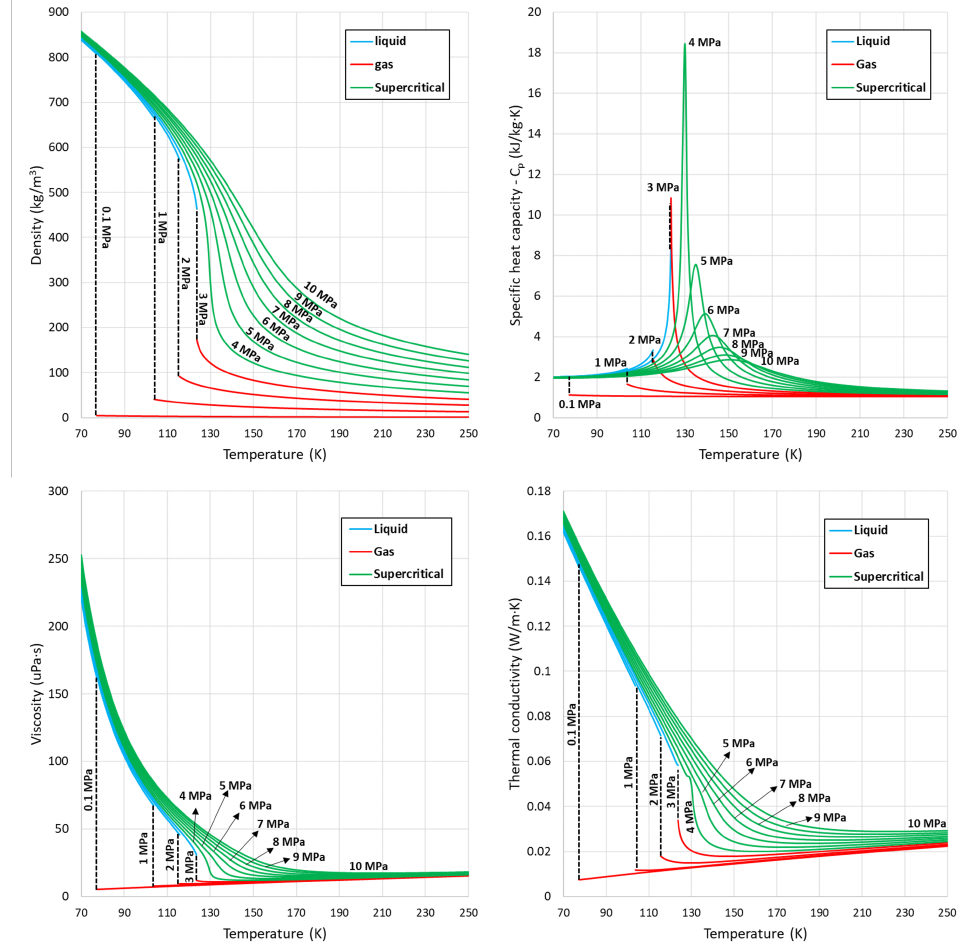
Figure 1. NIST data of density ( top-left ), specific heat capacity at constant pressure ( top-right ), vis- cosity ( bottom-left ) and thermal conductivity ( bottom-right ) for nitrogen at pressures from 0.1 MPa to 10 MPa, against temperature. Adapted from